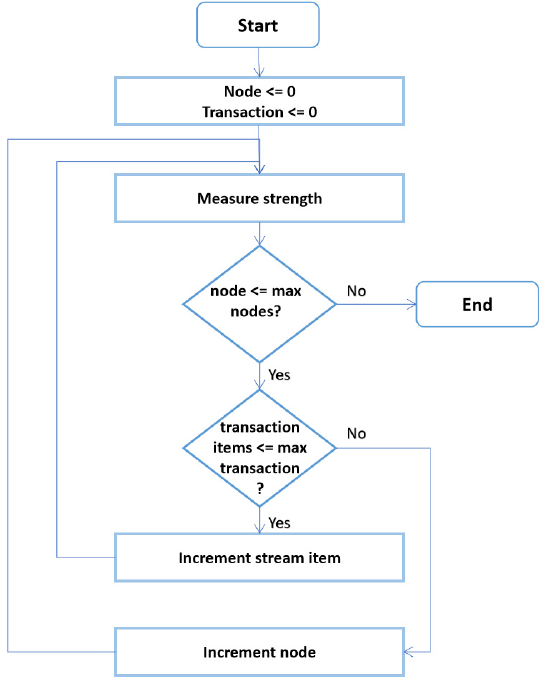
Figure 11. Flow diagram of IoT blockchain strength measurement.